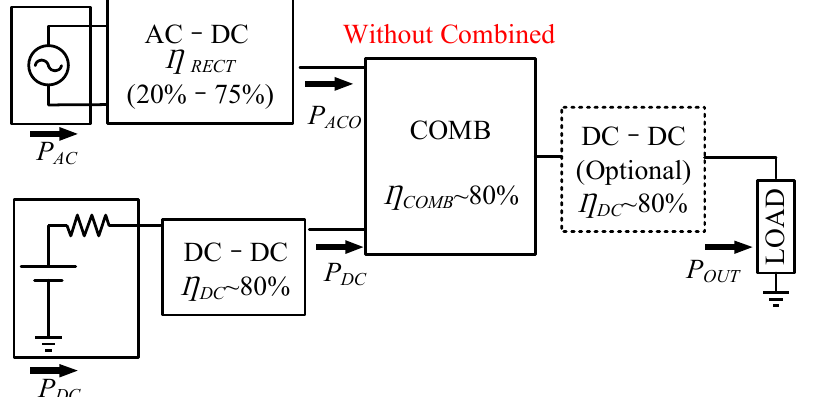
Figure 16. Conventional combiner system structure with mixed AC and DC harvesting.